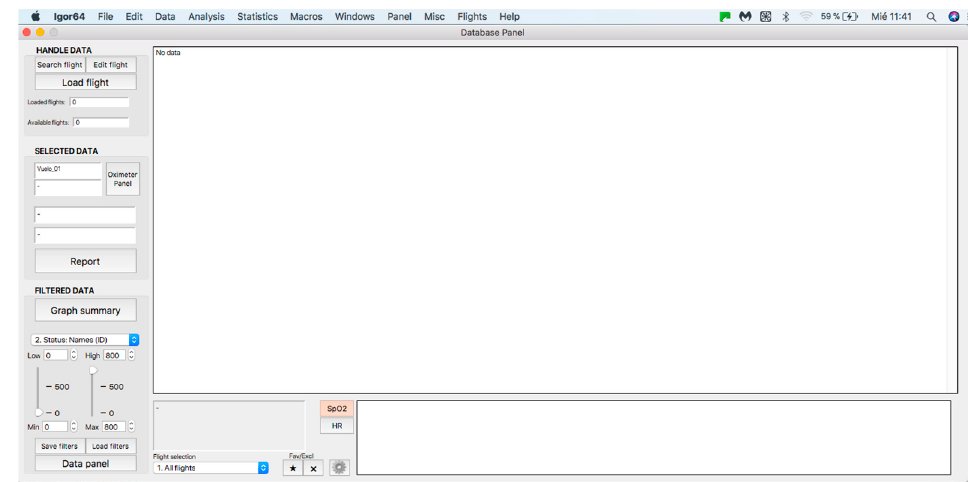
Figure 3. General panel of the database. Handle data—data loading and processing panel (see at the top). Selected data—panel for visualization and analysis of individual curves (see in the middle). Filtered data—filter application panel (see at the bottom).